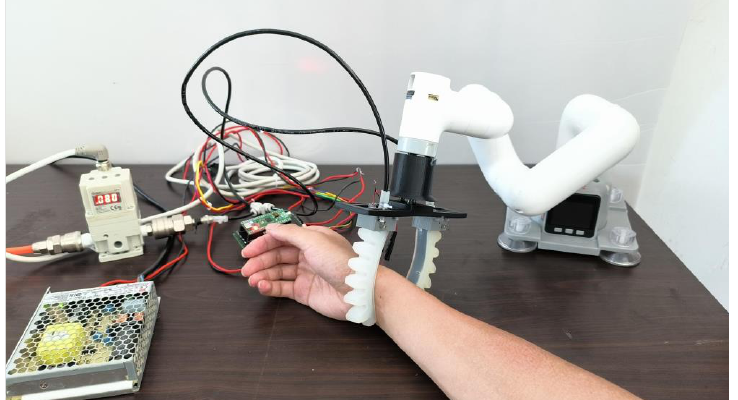
Figure 7. Picture of pulse detection with the STA.